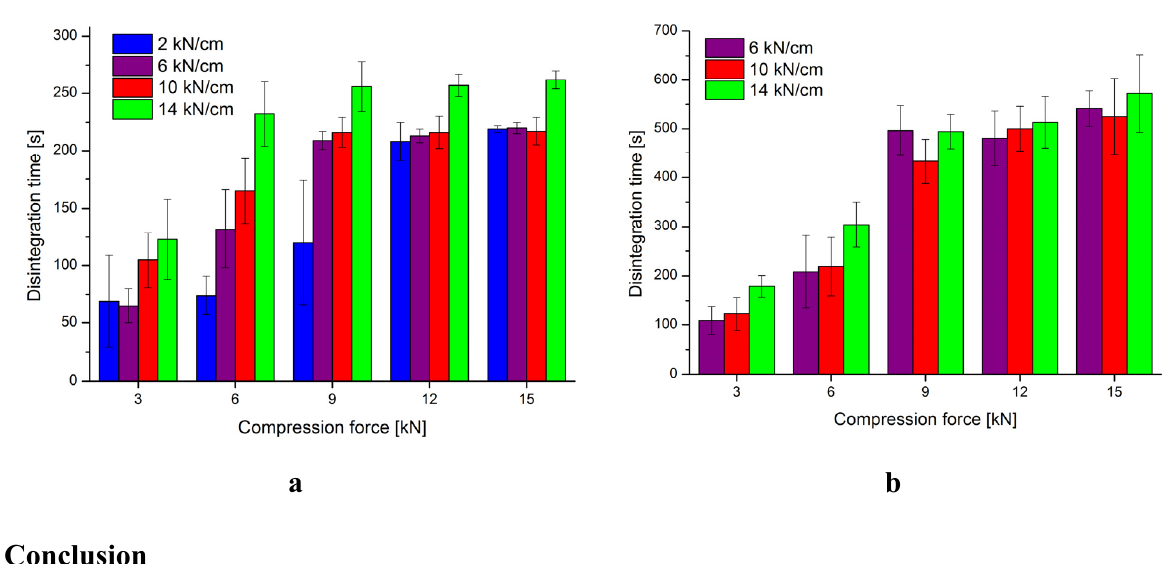
Figure 2. ( a ) Disintegration time of isomalt tablets. ( b ) Disintegration time of isomalt-DCP tablets. ( n = 6, mean ±